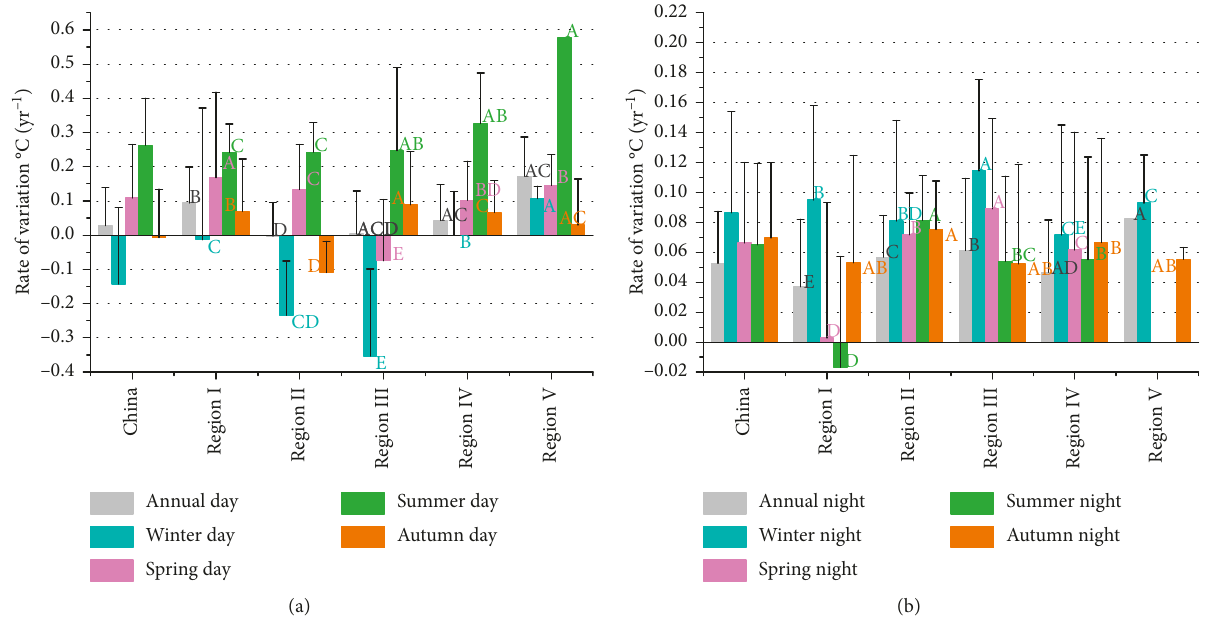
Figure 7: The statistical of variation rates of mean city SUHIIs that changed significantly throughout the year and during four seasons during the daytime and night-time from 2003 to 2013 in the five environmental regions of China (A–E represent the mean comparison results among regions, using nonparametric tests of k independent samples; significant differences only existed in rural LSTs among the five environmental regions when the label letters were the